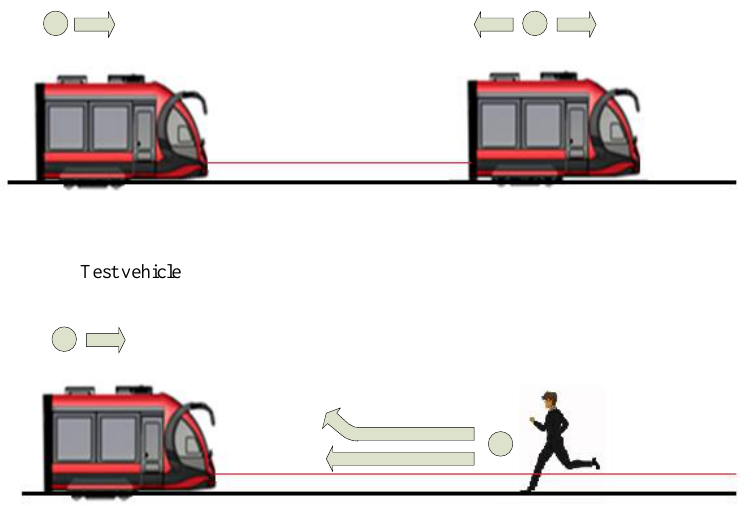
Figure 10. Scenarios for another Light Rail Vehicle (LRV) and Pedestrian.